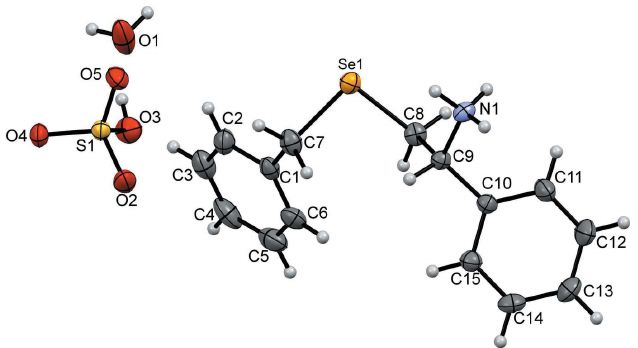
Figure 1 A view of the molecular structure of the title salt, with atom labelling. Displacement ellipsoids are drawn at the 50% probability